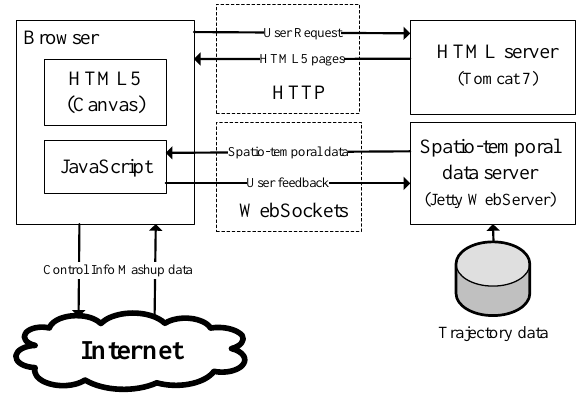
Figure 1. Visualization framework based on